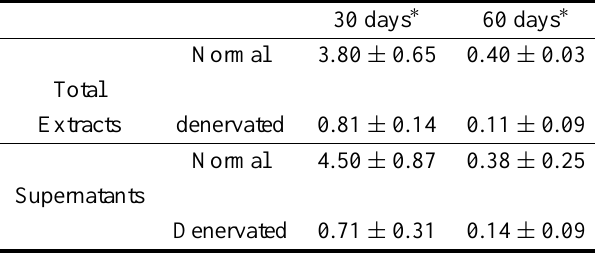
ChAT activity in Normal and Denervated main electric